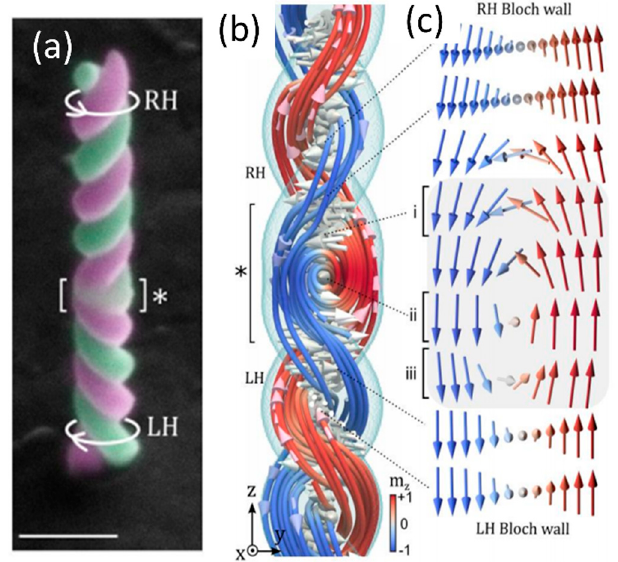
Figure 8. ( a ) Double-helix with opposite chirality (bottom LH: left-handed; top RH: right-handed) interfaced at the region marked by an asterisk. Scale bar is 1 µ m. ( b , c ) Micromagnetic simulations of the double-helix system in an antiparallel magnetic state; a Bloch wall with a well-defined chirality is formed between the strands, with the chirality defined by the chirality of the corresponding helix. A 3D vortex with a N é el defect is formed at the region (*) connecting both chiralities. Reproduced with permission from [98]. Copyright 2020 American Chemical Society.